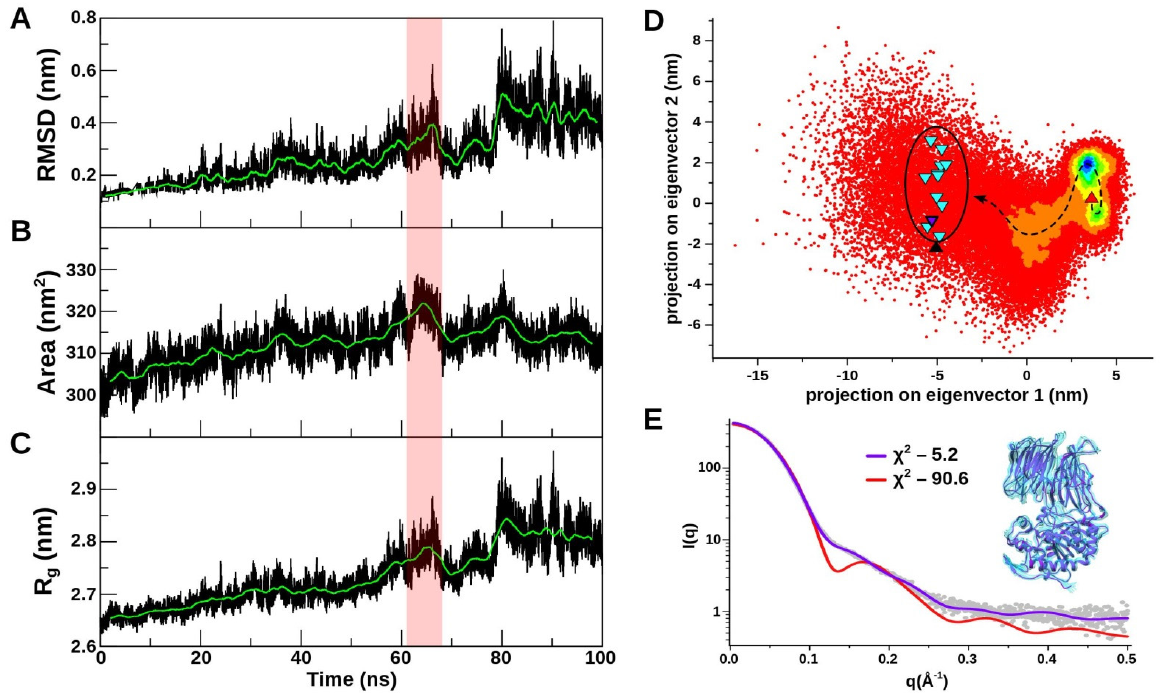
Figure 6. Comparison of the results of the ED/MD simulation of SpOPB with thee SAXS data and the SpOPBS532A crystal structure. The EDS trajectory (100 ns) obtained for SpOPB using six eigenvectors of the main motions (modes) from the correlation analysis (PCA) according to the classical MD. ( A ) The RMSD of the Ca atoms during the MD trajectory. ( B ) Change in the SASA for protein. ( C ) Change in the radius of gyration (R g ). The MD parameters corresponded to the classic MD with the exception of the settings for EDS. The total number of frames was 25,000. The trajectory section highlighted in red was used for the comparative analysis with the SAXS data obtained for the free SpOPB. This section had an Rg value in the range from 2.75 nm. ( D ) The projection of the combined EDS trajectory onto the two ‐ dimensional space was defined by the first two eigenvectors. Each point in space denotes a separate structure. The density of points on the projection is determined by color (the transition from red to blue corresponds to an increase in density). The dashed line indicates the approximate direction of the trajectory (from the starting structure). Triangles denote the conformational positions of the selected structures. The colors of the triangles are as follows: red is the initial crystal structure of SpOPB in the intermediate state, black is a homologous model of the open conformation of the protein, triangles with the top down are the best structures from EDS, purple is for the best fit to the SAXS data. ( E ) Experimental SAXS profile for the spermine ‐ free SpOPB (gray dots) with the superimposition of the theoretical curves for the best EDS structure (violet line) and the SpOPBS532A crystal structure (red line). The insert shows the aligned 12 best structures from the EDS (the structure with the best hi2 is purple, the rest are turquoise).